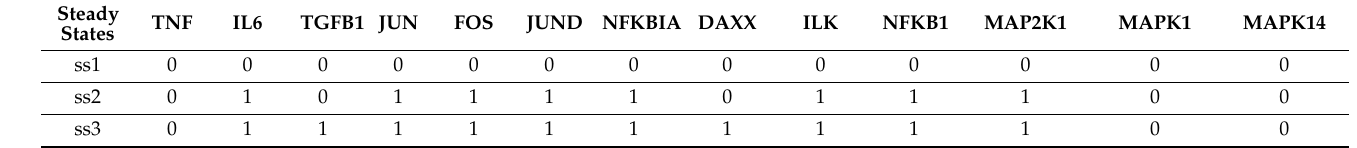
Table 5. Stable states of the Boolean network (MAPK1, MAPK14 KO, input TNF = 0).